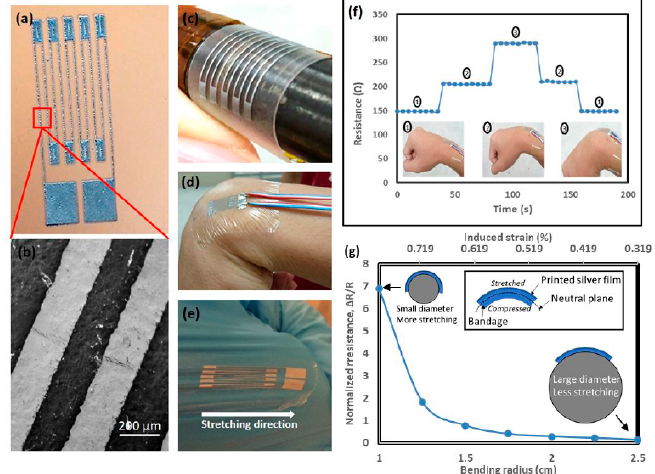
Figure 13. ( a ) The aerosol jet-printed strain sensor consisting of bandage as the substrate and ( b ) silver nanoparticles as electrodes in the form of electrical tracks. The sensors had ( c ) a small bending radius of curvature that assisted them to be stuck to ( d ) a human wrist. ( e ) The responses of the sensors were highly repeatable when they were attached to ( f ) the elbow, to analyze their bending. ( g ) The change in relative resistance with respect to the bending radius [62] .